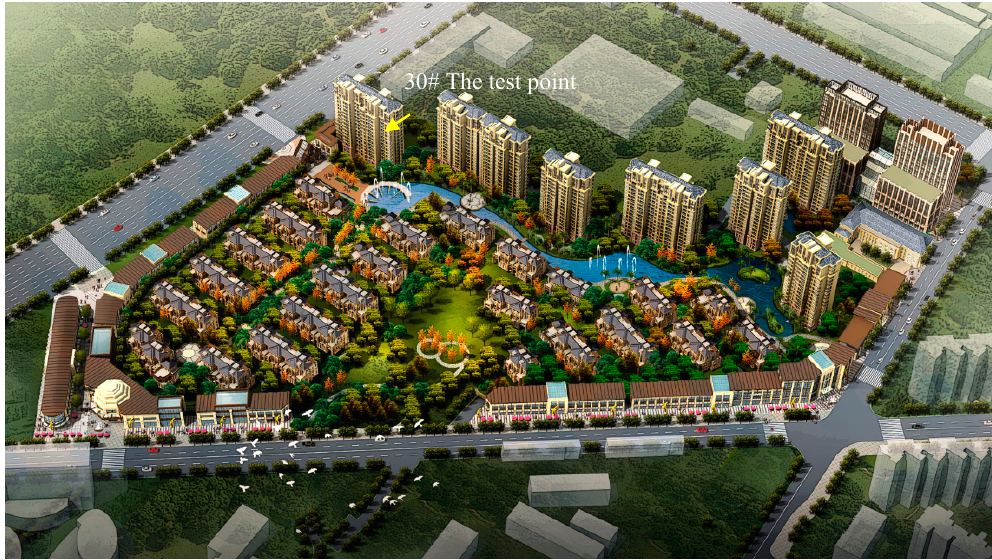
Figure 9. The location of the high-rise residential buildings in Sanxiang Haishang Cheng community.